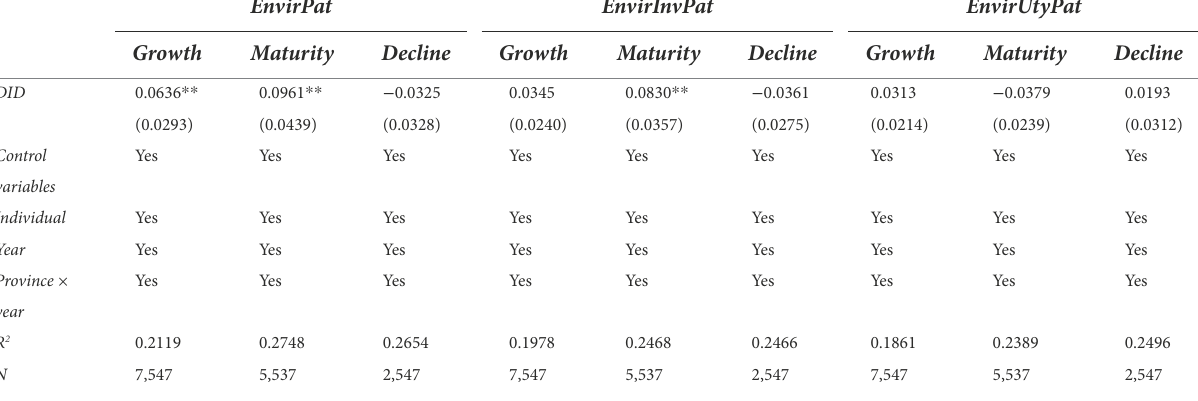
TABLE 9 The heterogeneity of enterprise life cycle.